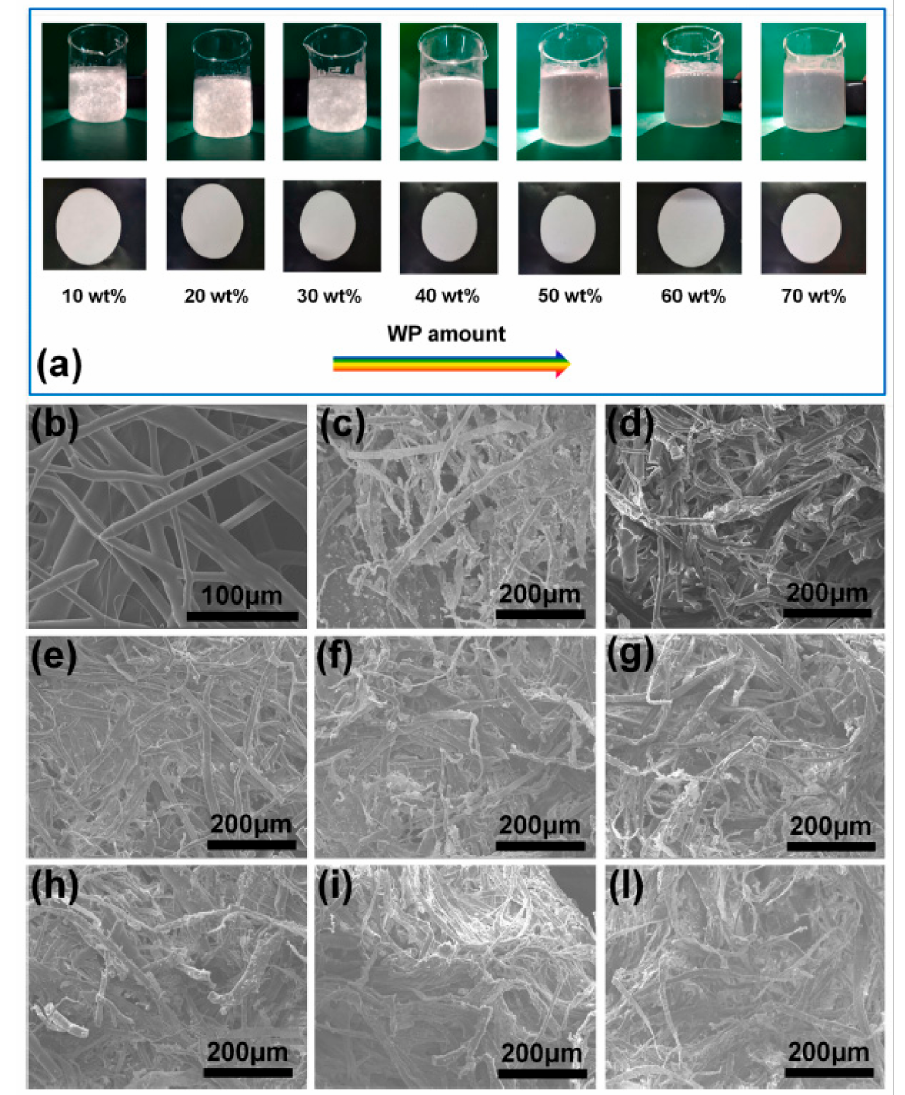
Figure 16. ( a ) Photographs of WP/PBS pulp suspension. SEM images of WP/PBS composites at various WP contents showing the distribution of the plant fibers in WP are shown in: ( b ) pure PBS, ( c ) pure WP, ( d ) 10 wt%, ( e ) 20 wt% WP, ( f ) 30 wt% WP, ( g ) 40 wt% WP, ( h ) 50 wt% WP, ( i ) 60 wt% WP and ( l ) 70 wt% WP [125]. Copyrights obtained from